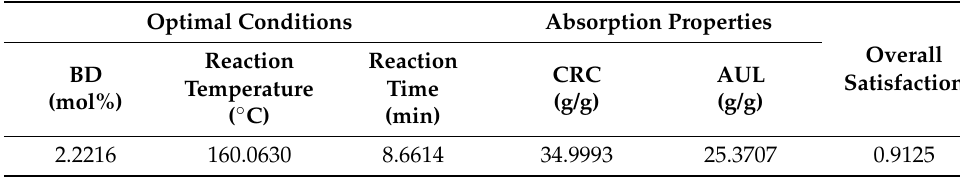
Table 2. Optimum conditions derived by CCD of RSM design